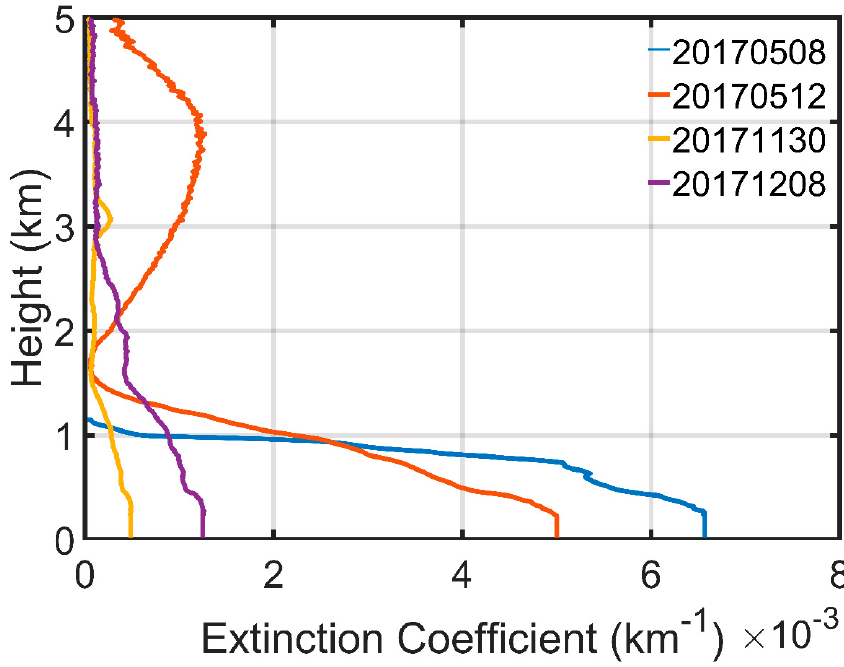
Figure 5. Example of observed aerosol extinction profiles by MPL(micro-pulse lidar) at Beijing-PKU site. Only profiles below 5 km are shown in this figure.